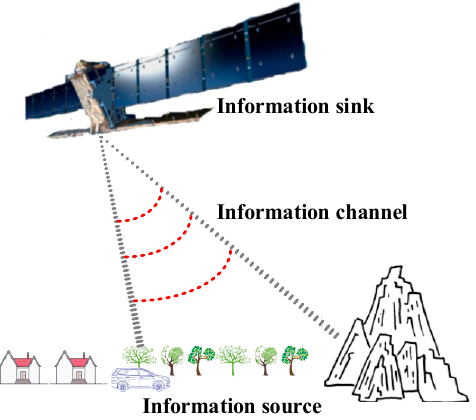
Figure 2. Analogous to the communication system in information theory, the scene, the mapping relation, and the echo correspond to information source, channel, and sink, respectively.